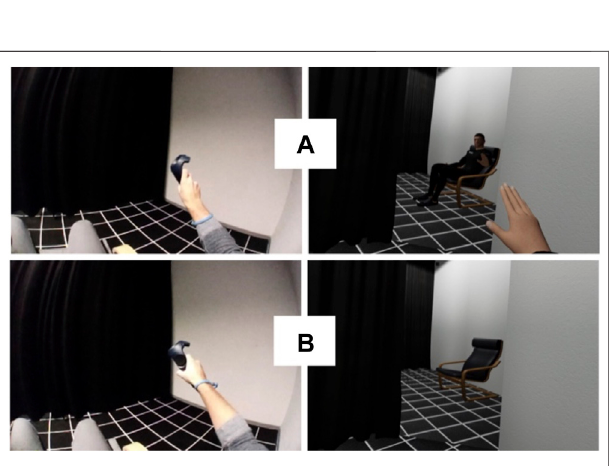
FIGURE 3 | Participant looks in the virtual mirror (A) with avatar, (B) without avatar.